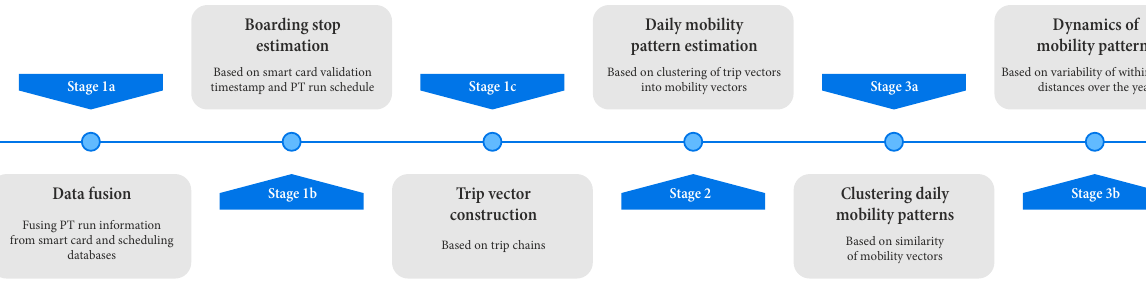
Figure 4. Stages of the research